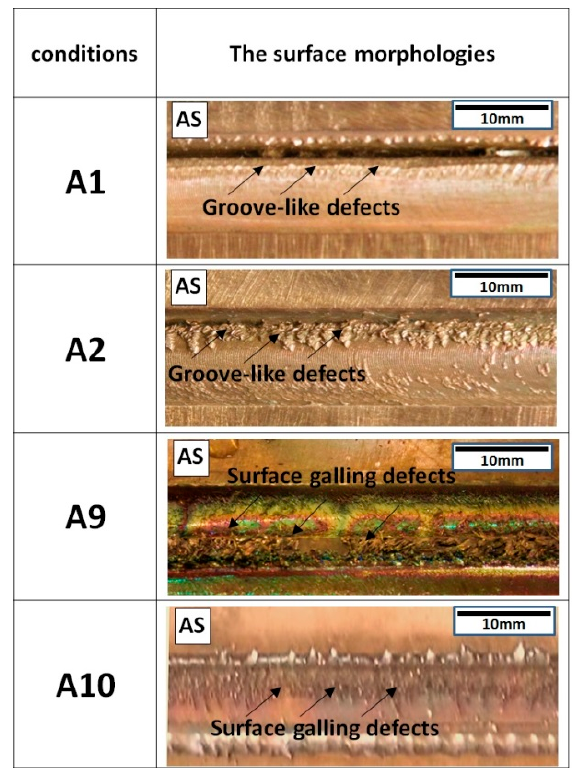
Figure 2. The surface morphologies of dissimilar CuCrZr/CuNiCrSi butt joints under conditions A1, A2, A9, and A10.